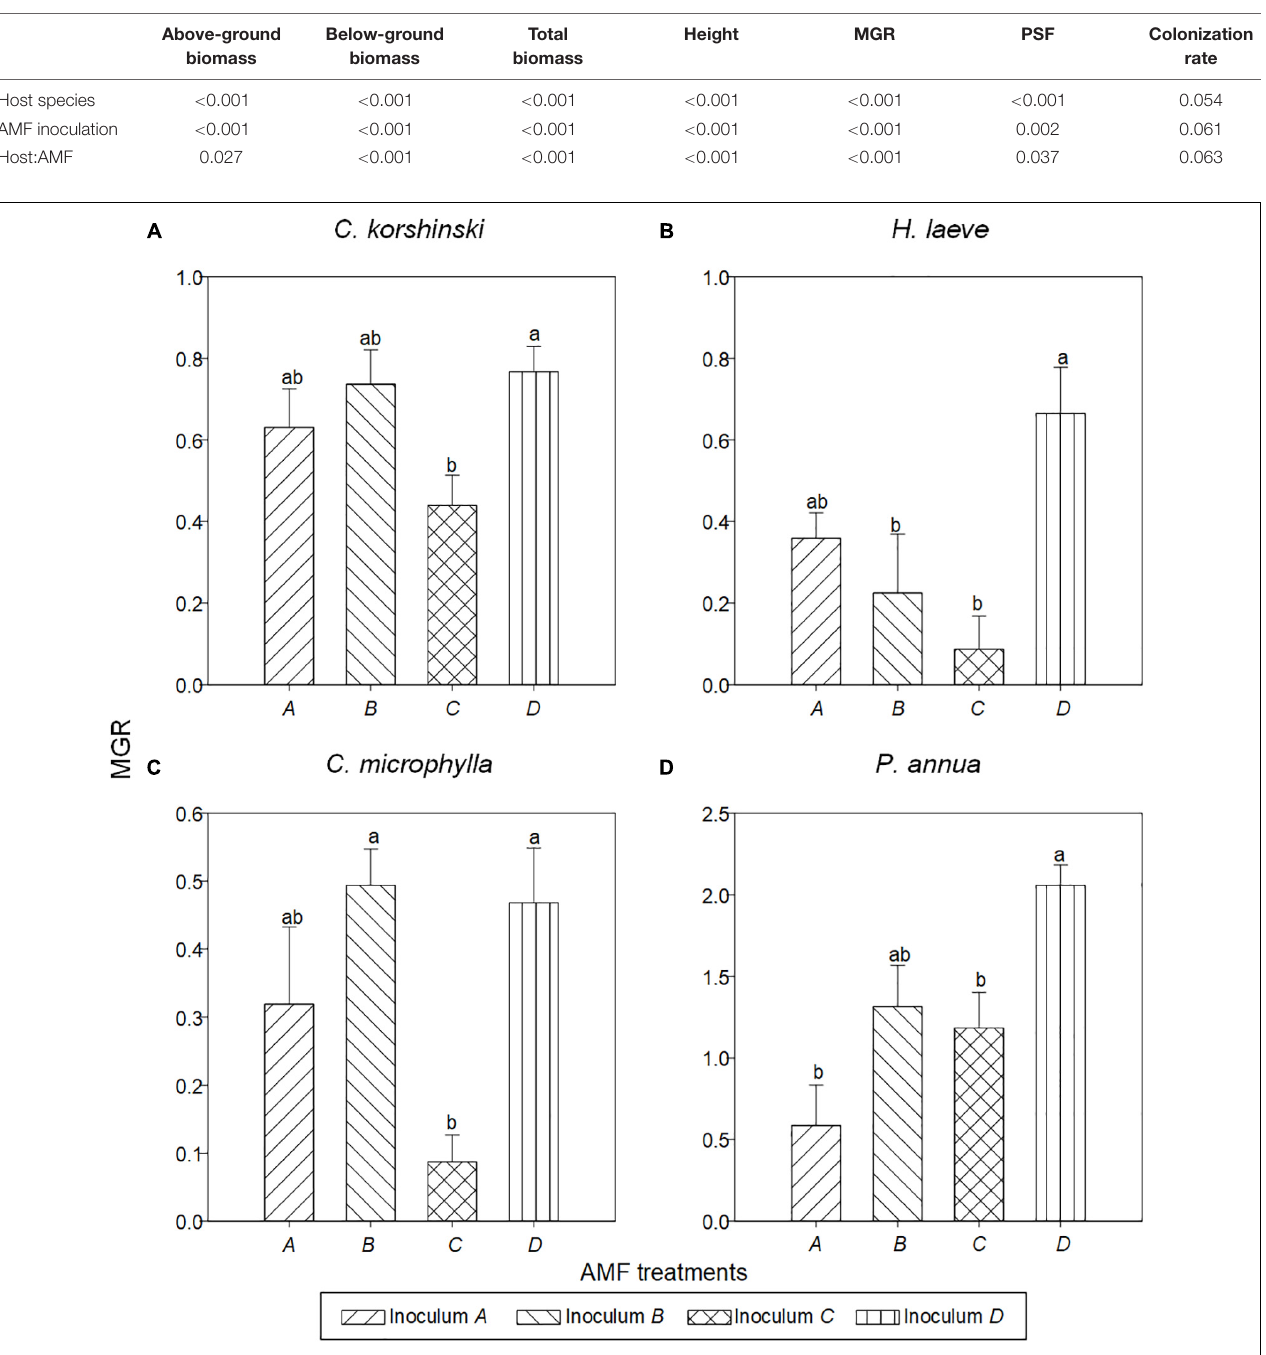
TABLE 2 | Results ( p -value) of two-way ANOVA showing the effects of host plant species, AMF inoculation, and their interactions on plant performance.